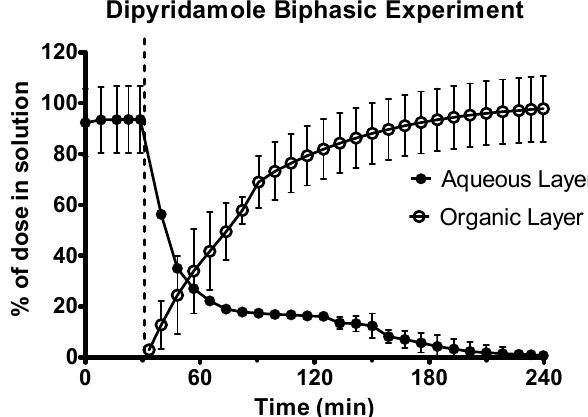
Figure 4. Drug release time profile for the dipyridamole oral suspension, dose equivalent to 10 mg active pharmaceutical ingredient (API). Aqueous layer release is represented by filled circles. Organic layer data are represented by the hollowed circles. Dotted line indicates transition from gastric sector to intestinal sector. Each data point represents the mean ± SD ( n = 3).